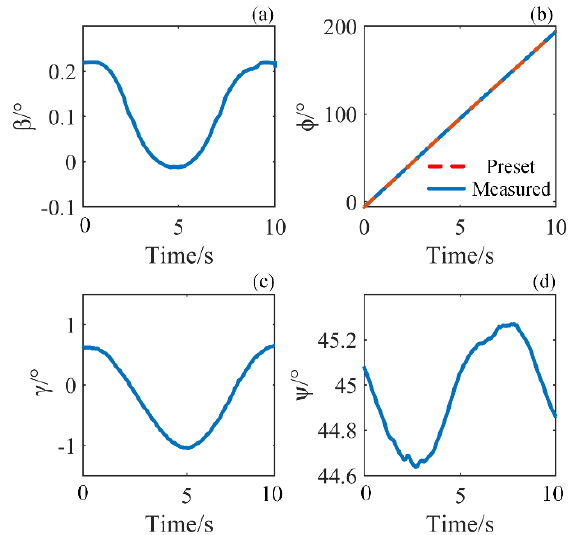
Figure 6 The measurands extracted from the Muller matrix in the normal incidence experiments: (a) incident angle β over time; (b) the preset and measured roll ϕ over time; (c) the optical rotation angle γ over time; (d) the polarimetric angle ψ over